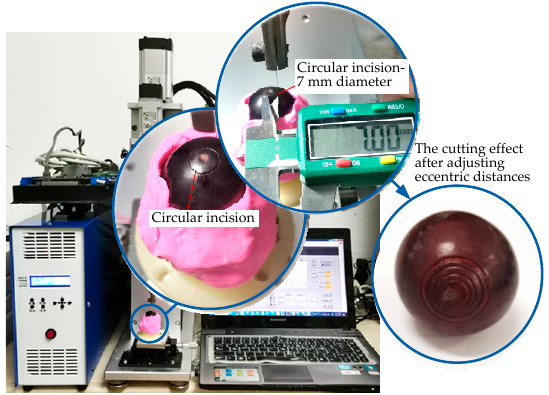
Figure 15. Validity verification experiment of the eccentric adjusting mechanism.